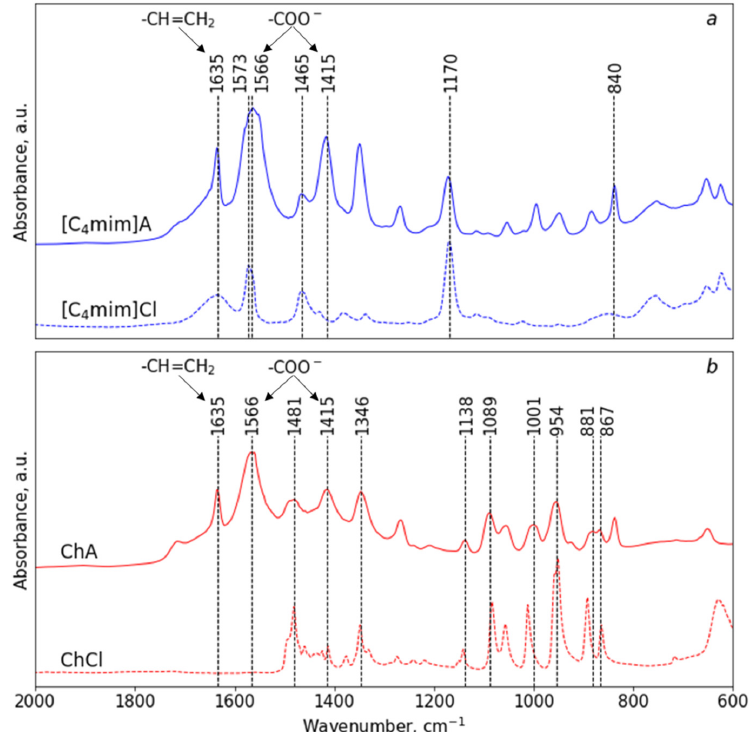
Figure 1. FTIR spectra of the starting imidazolium chloride and resulting [C 4 mim]A ( a ); starting choline chloride, and resulting ChA ( b ).